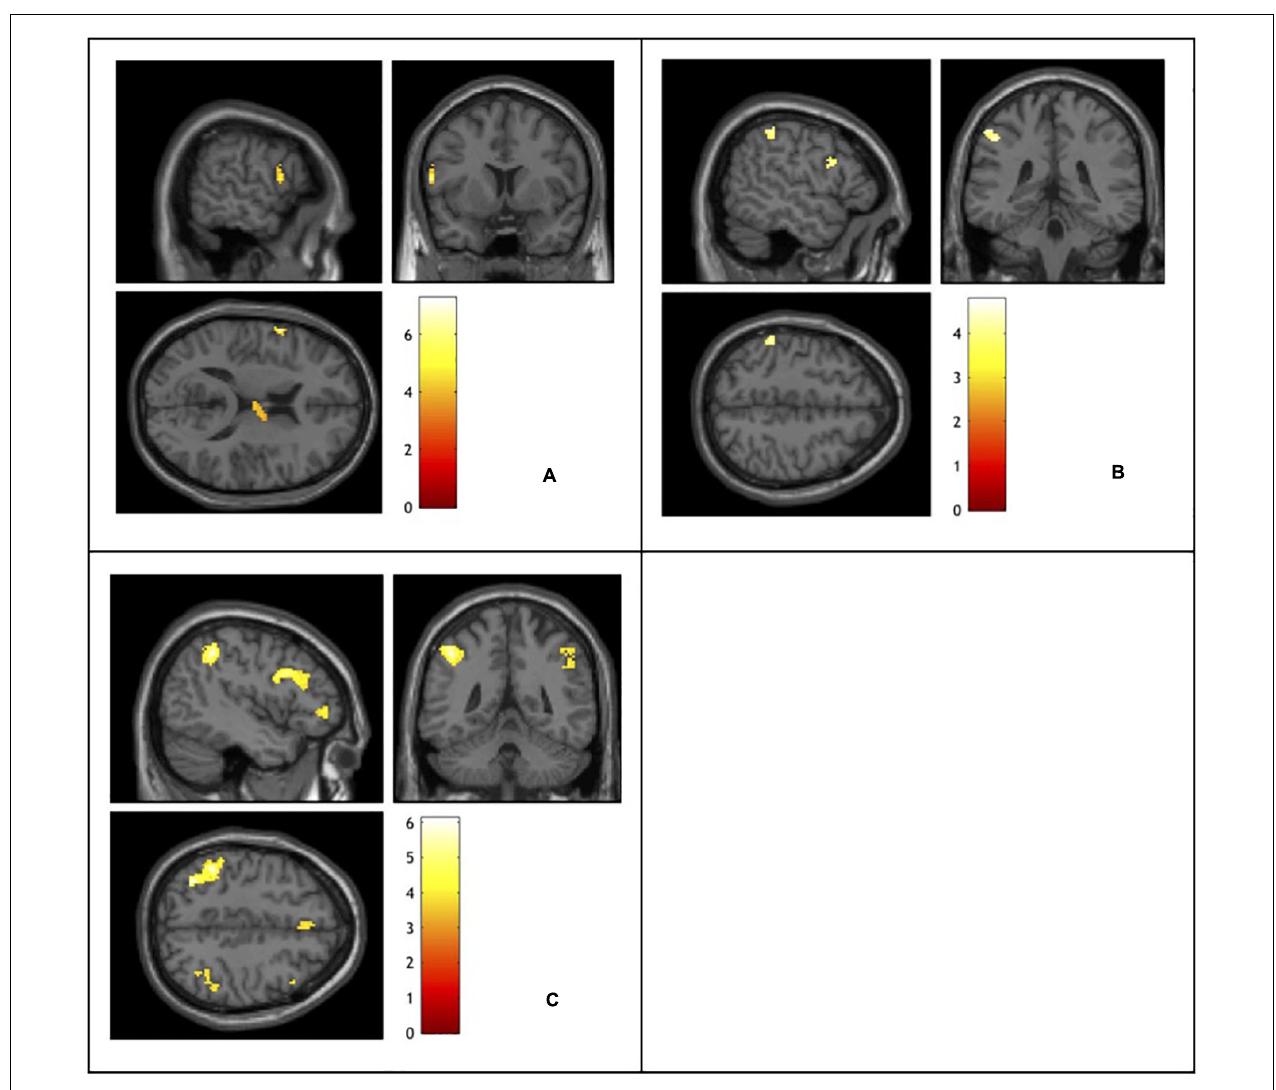
FIGURE 2 | Functional magnetic resonance imaging activation elicited by: (A) semantic conflict indexed using a non-response set – neutral words contrast. (B) Response conflict indexed using an incongruent – semantic associates contrast. (C) Stroop interference indexed using an incongruent – neutral words contrast. Activation color represents t